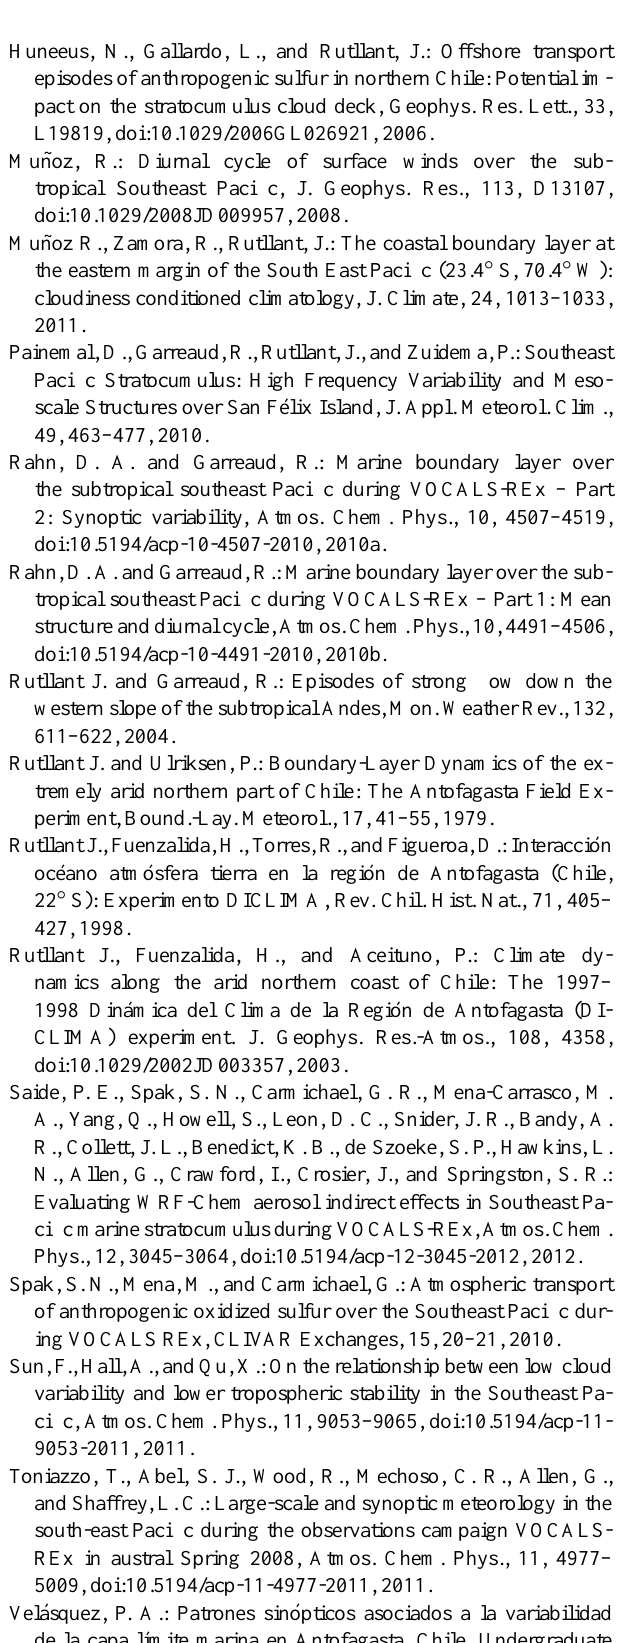
Figueroa, D. and Moffat, C.: On the influence of topography in the induction of coastal upwelling along the Chilean coast,